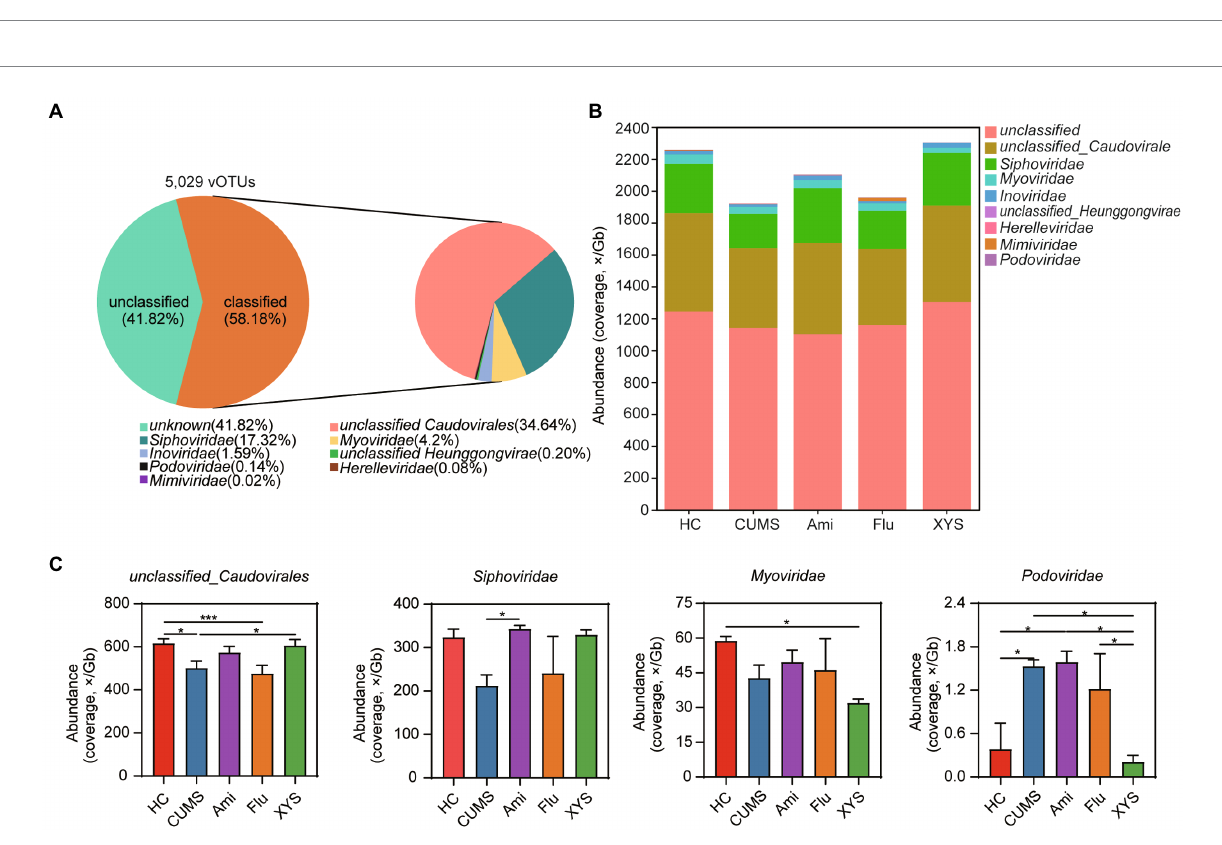
FIGURE 1 The gut virome biodiversity alterations following Ami, Flu and XYS treatment. (A) Comparison of viral alpha-diversity based on Shannon diversity index and Sobs richness index. (B) NMDS based on the Bray–Curtis distance showed distinct clusters of gut viruses in CUMS model rats from the Ami, Flu and XYS therapy, respectively. p values were determined by Kruskal–Wallis test. * p < 0.05, ** p < 0.01, *** p < 0.001.